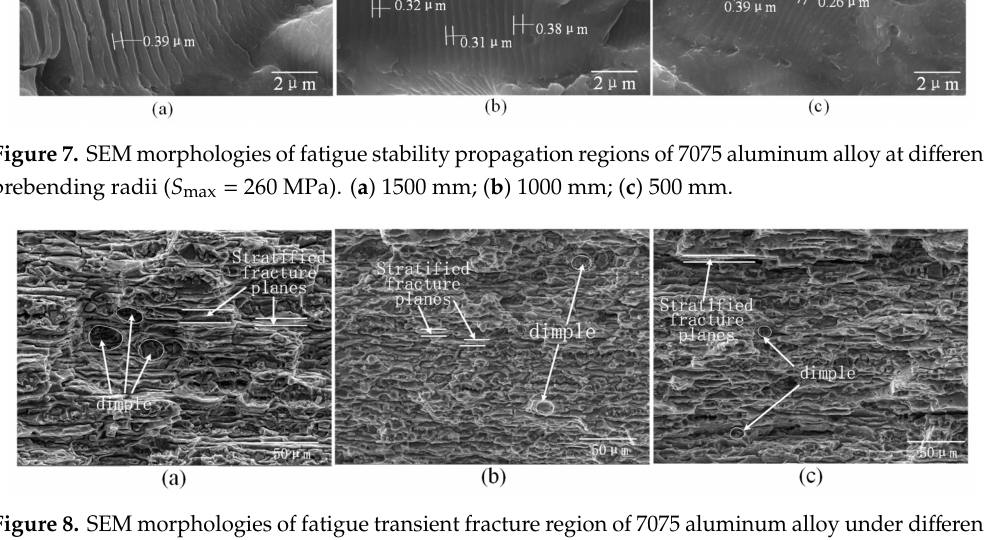
Figure 8. SEM morphologies of fatigue transient fracture region of 7075 aluminum alloy under di ff erent prebending radii ( S max = 260 MPa). ( a ) 1500 mm; ( b ) 1000 mm; ( c ) 500